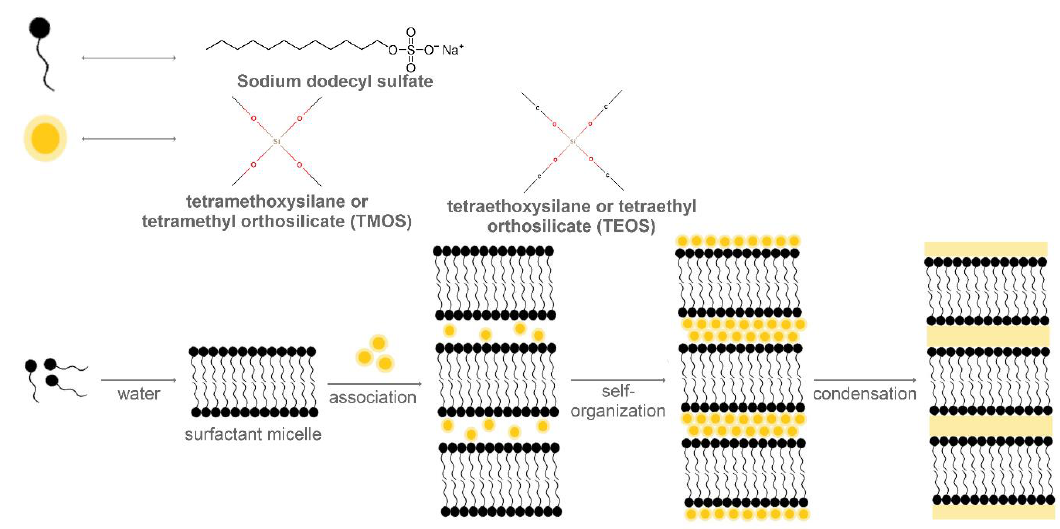
Figure 4. A schematic diagram of the processes involved in the synthesis of MCM-50.